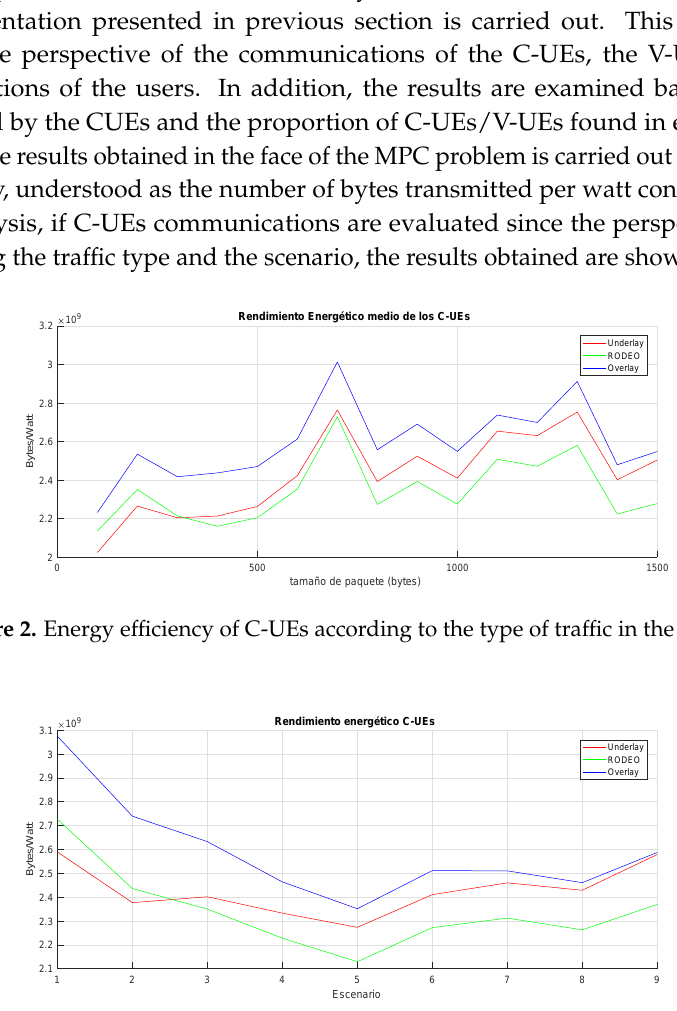
Figure 3. Energy efficiency of C-UEs depending on the